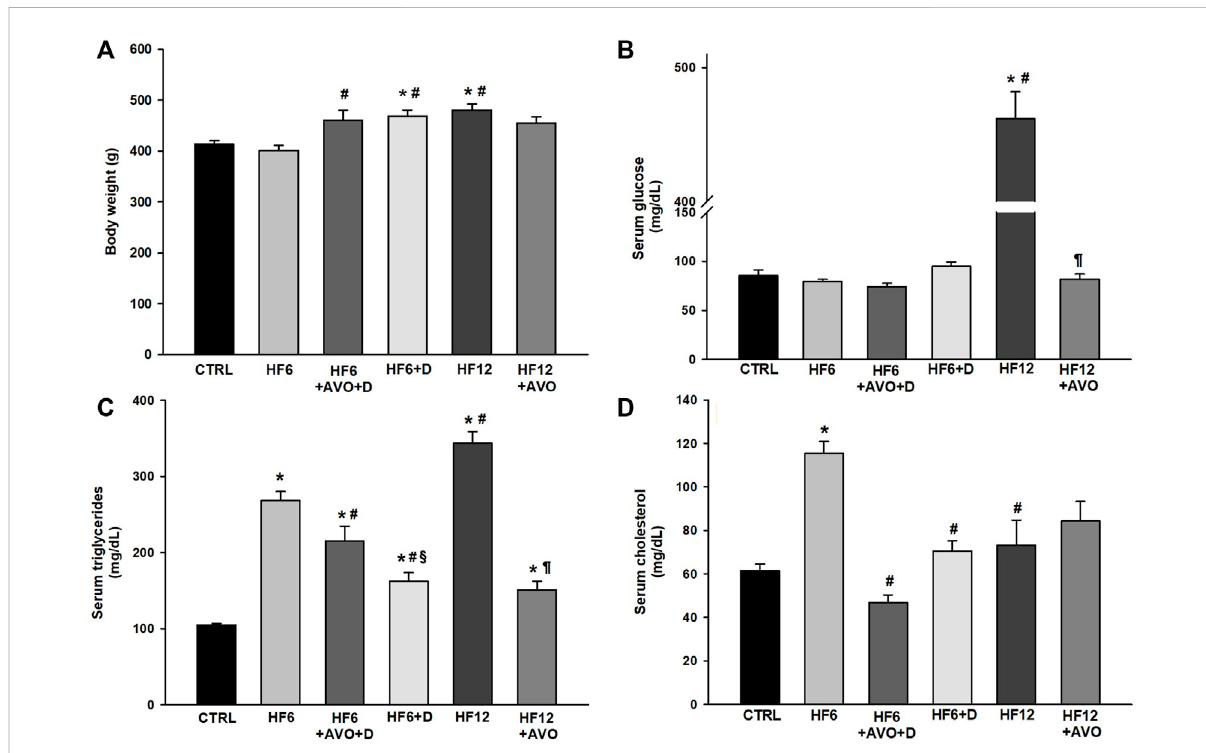
FIGURE 2 Effects of avocado oil on body weight (A) , blood levels of glucose (B) , triglycerides (C) , and cholesterol (D) . Data are expressed as the mean ± standard error of n ≥ 4. * p < 0.05 vs. CTRL; # p < 0.05 vs. HF6; § p < 0.05 vs. HF6+AVO + D; ¶ p < 0.05 vs. HF12 (ANOVA, Holm- Š ídák ’ s post hoc